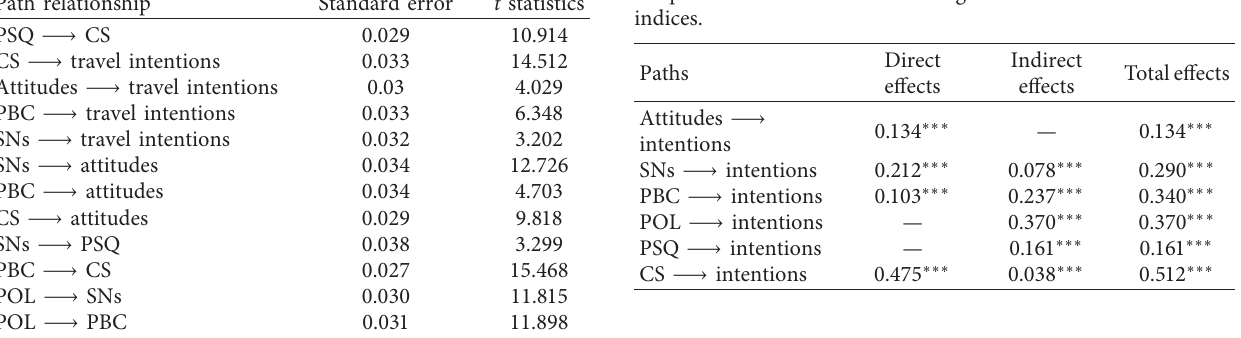
Table 6: Bootstrapping test results of the path coefficients. Table